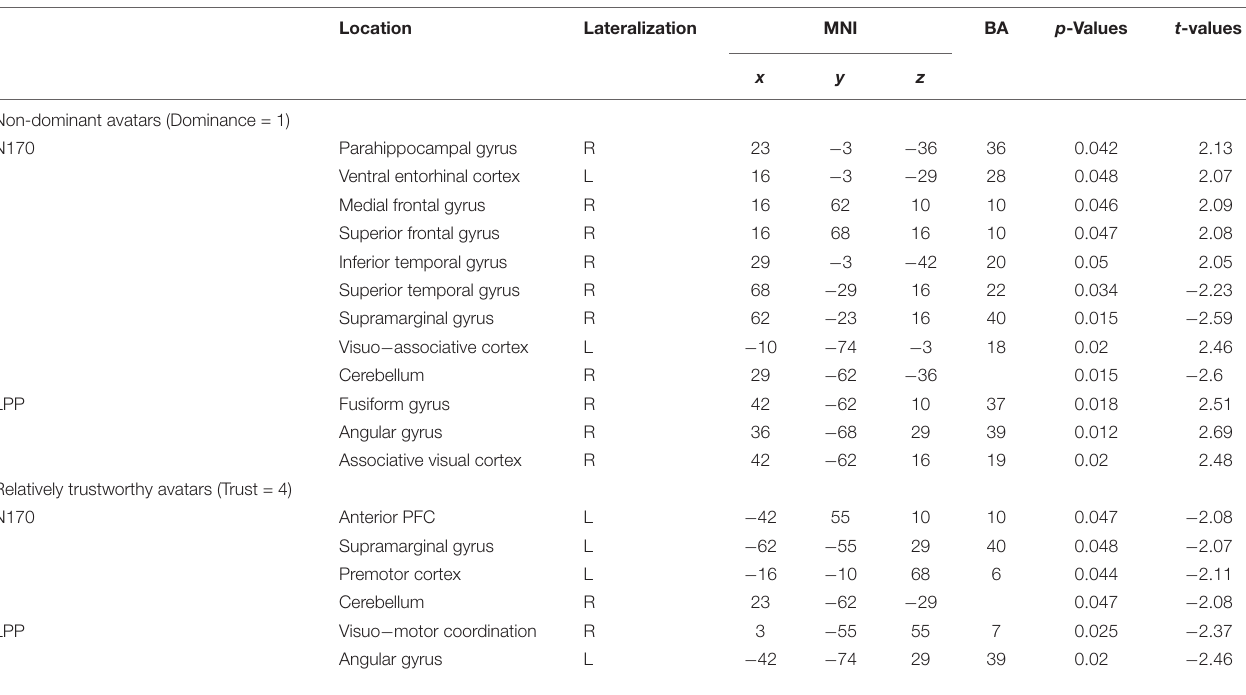
TABLE 3 | EEG source analysis